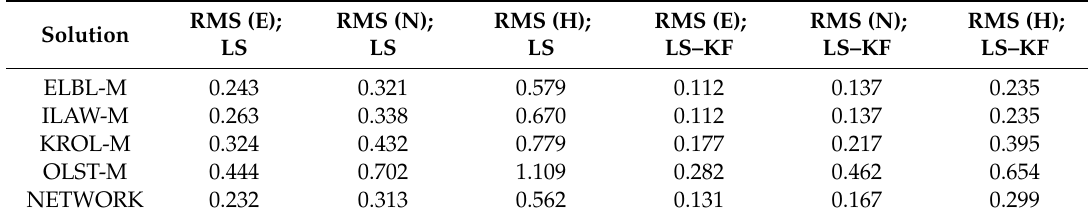
Figure 4. Real errors of network DGPS positioning based on least squares solutions and Kalman filtering (KF) for session I. Table 1. Statistical characteristics of the DGPS network positioning results for session I (meters).